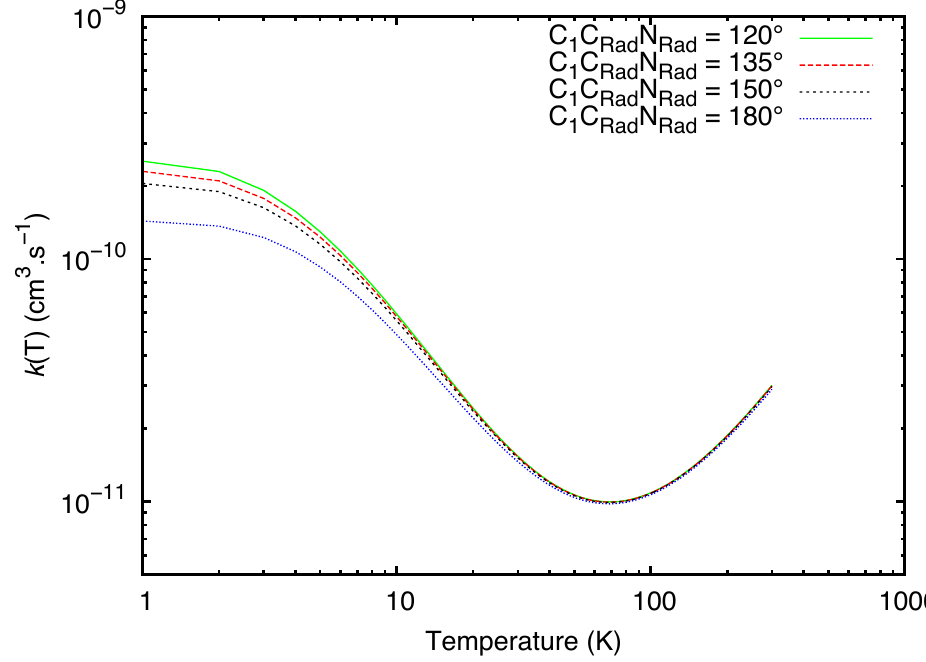
(cid:92) C 1 C Rad N Rad angles (in degrees).